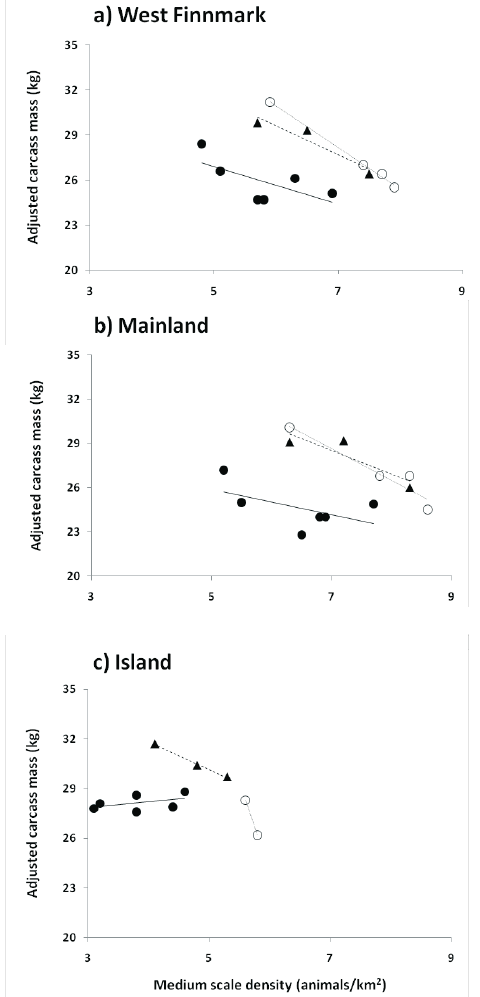
Fig. 3. LS means carcass mass of male yearlings adjusted for slaughter date, period and sub-region (mainland and island) plotted against annual net summer density at West-Finnmark scale (a) and LS means carcass mass of male yearlings adjusted for date of slaughter, period and districts plotted against annual net summer density at mainland (b) and island (c) scales. White symbols represent period 1 (1983-1987, missing data for year 1984), black filled symbols represent period 2 (1996-2001) and black filled triangles represent period 3 (2002- 2005). The clear dashed line is the fitted line for period 1, the solid line is the fitted line for period 2, while the weak spotted line is the fitted line for period